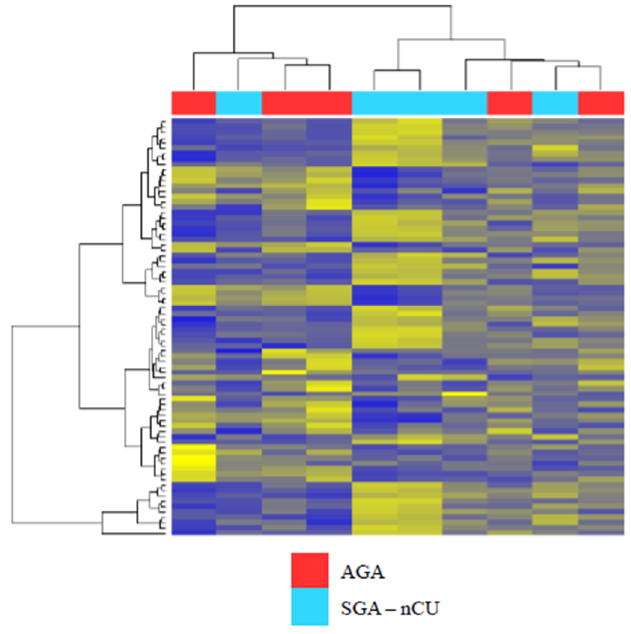
Figure 1. Heat map of the Z-scores of serum miRNAs for the SGA-nCU (n = 5) and AGA (n = 5) groups revealing that serum miRNA expression did not cluster in the two groups. Blue: Z score < − 2.0. Yellow: Z score > 2.0. Table 3. Fold change in miRNA expression in the SGA-nCU group compared with the AGA group.